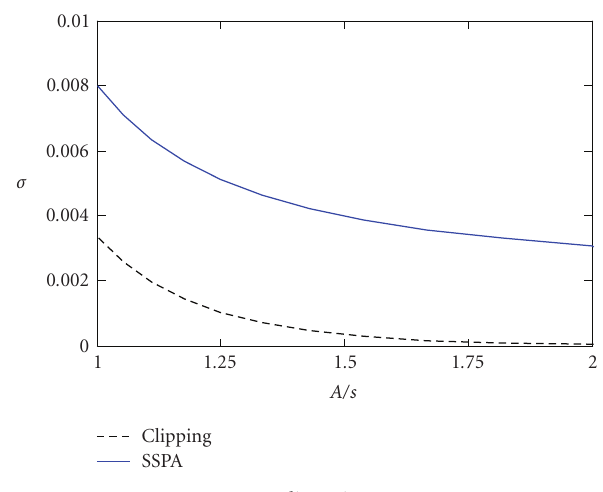
Figure 8: NLA distortion versus A/s .